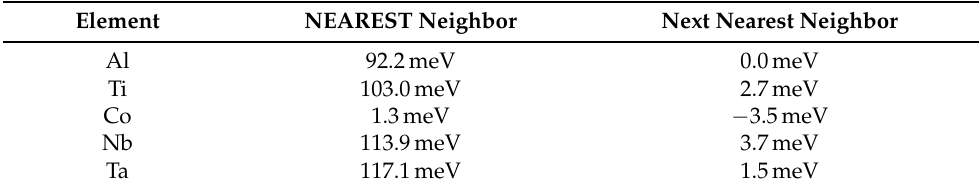
Table 1. Interaction energy between Co and other alloying atoms calculated in a matrix with 108 atoms. Energies shown are for nearest neighbor and next-nearest-neighbor positions.